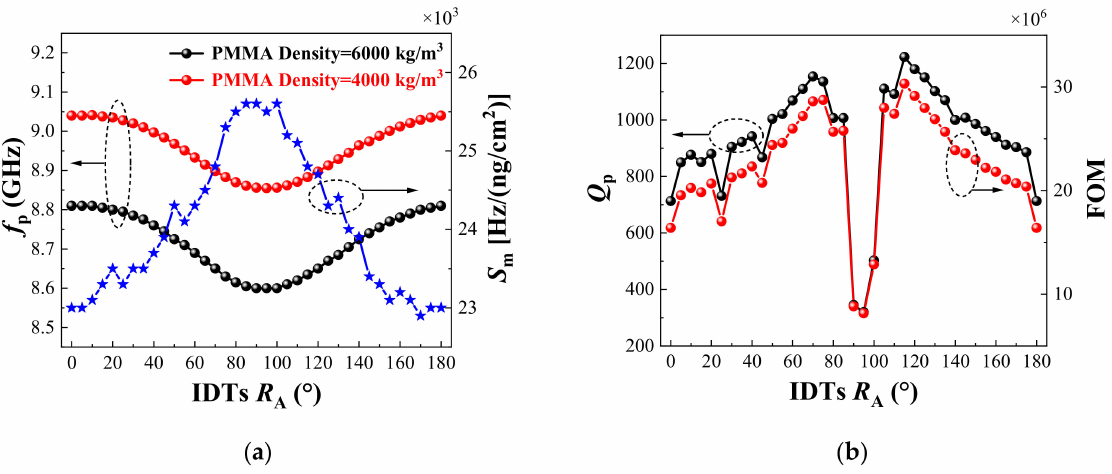
Figure 7. Variation of ( a ) f p , S m , and ( b ) Q p , FOM of biosensors with different IDTs rotation